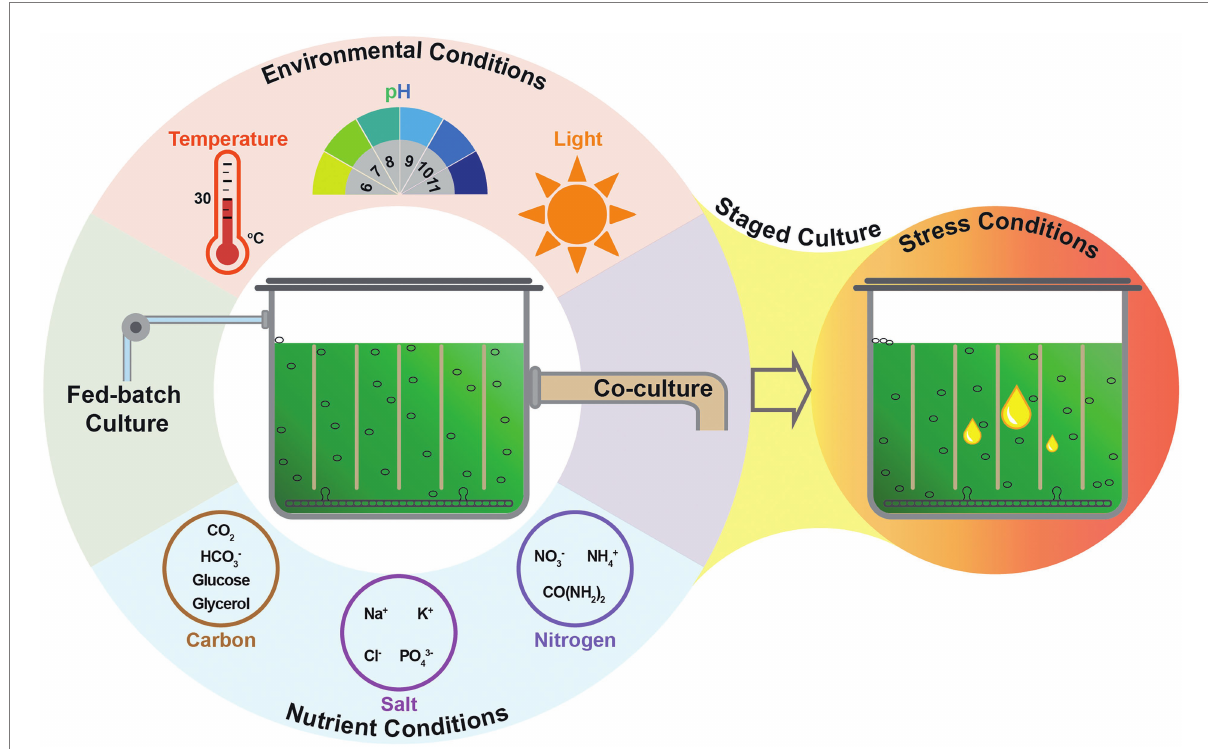
FIGURE 2 Systematic strategies of cultivation process tailoring microalgae for enhanced lipid